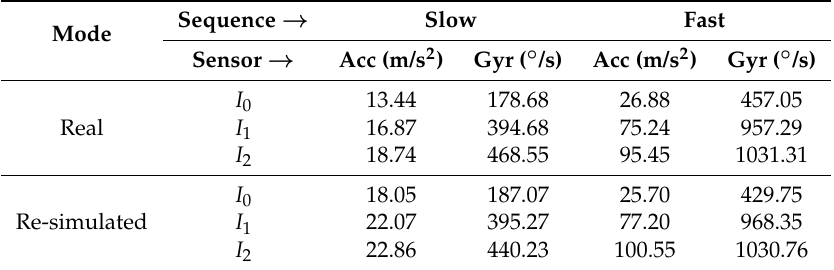
Table 2. Measured/simulated instantaneous peak acceleration (Acc) and angular velocity (Gyr) 2-norms for real-slow , real-fast , sim-slow and sim-fast